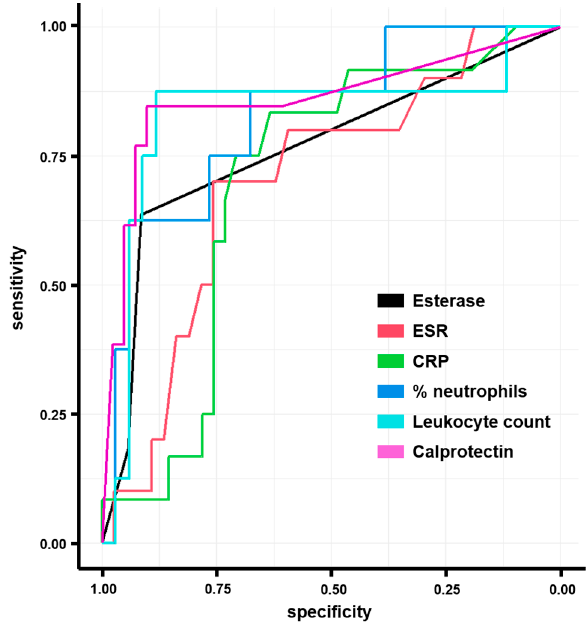
Figure 2. ROC curves for the tests based on serum and synovial markers. The linear relationship between calprotectin values and the other PJI biomarkers is displayed in Table 4. Calprotectin levels were significantly different depending on the result of the esterase test (Figure 3). Table 4. Correlation matrix depicting the correlation coefficients ρ (with p -values) between calpro- tectin and the tested PJI biomarkers.